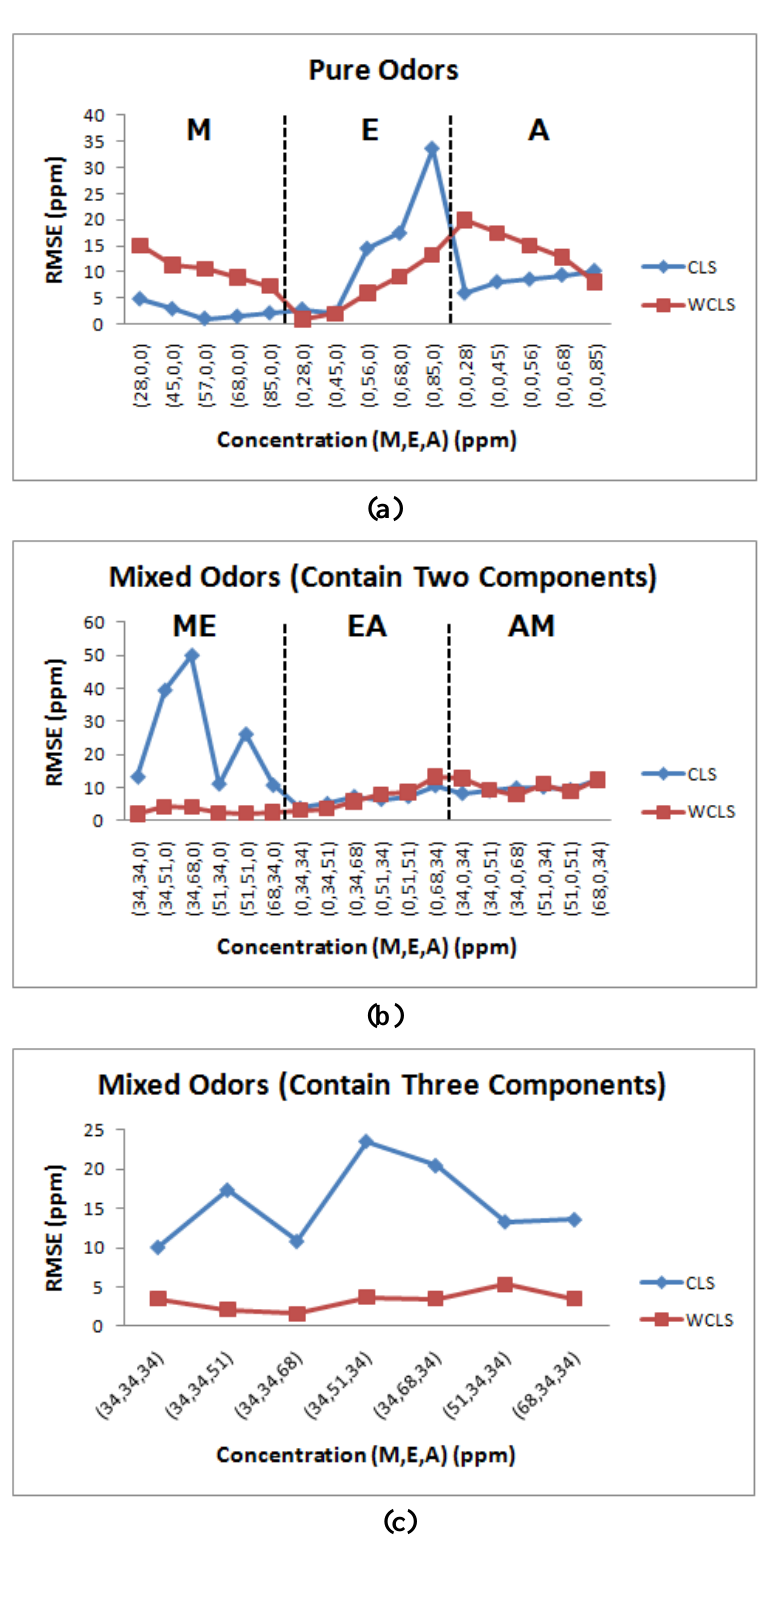
Figure 6. The estimated errors of the CLS method and the proposed WCLS over the testing dataset for (a) pure odors, (b) mixed odors (two components), and (c) mixed odors (three